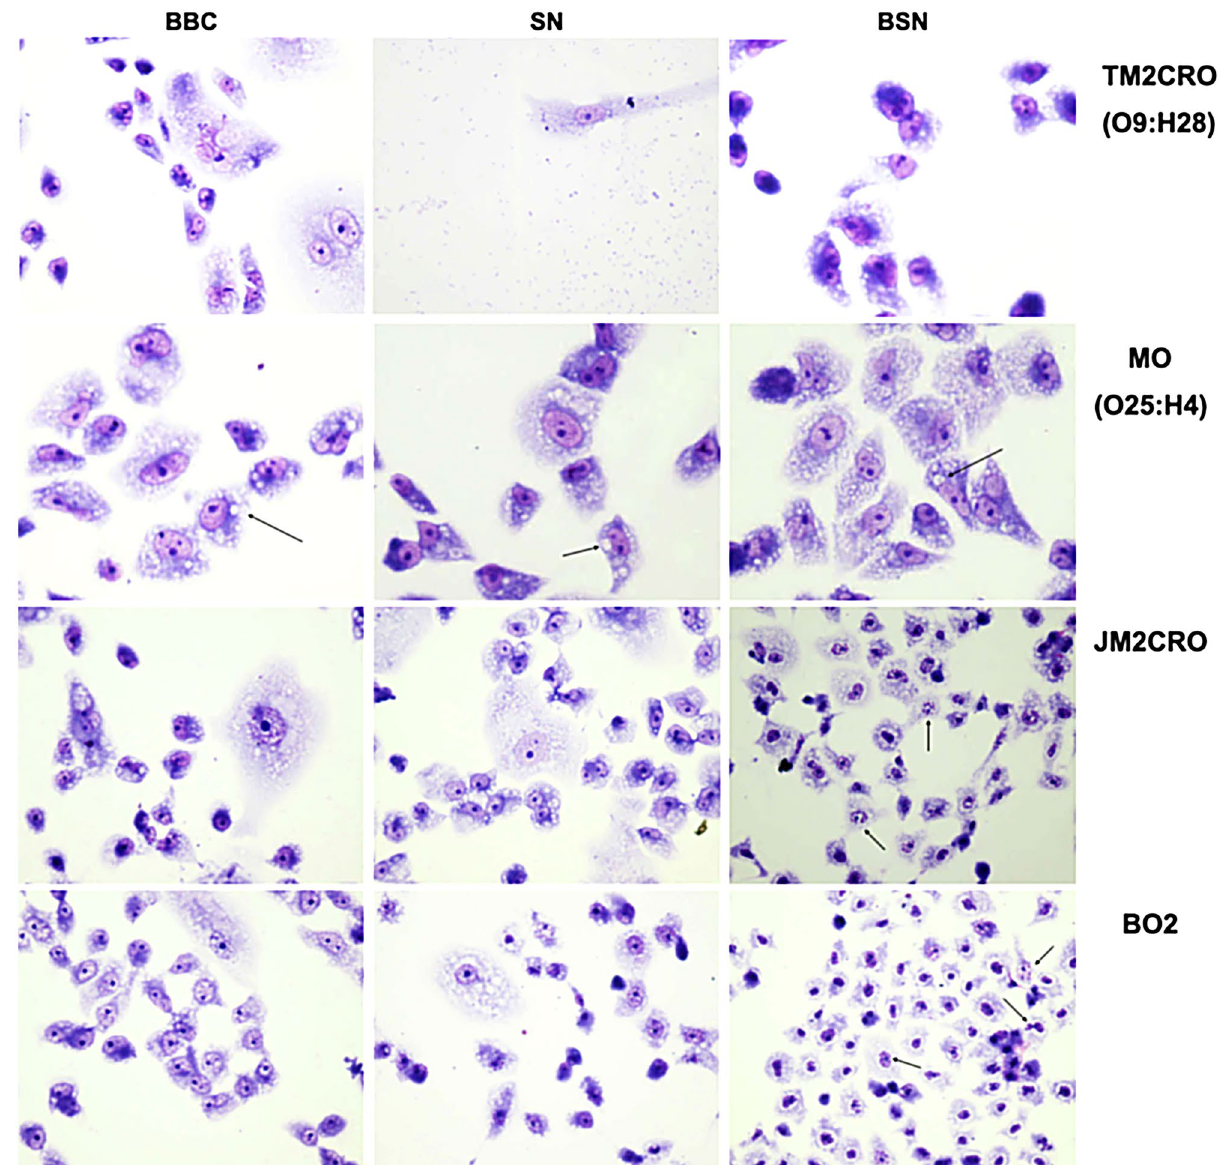
Figure 5. Cytotoxic assay on Vero cells. BBC, boiled bacterial cells; SN, supernatant; BSN, boiled supernatant. Arrows point to vacuollation and nuclear damage induced by E. coli MO (O25:H4), and K. pneumoniae JM2CRO and BO2 strains, respectively. Magnification